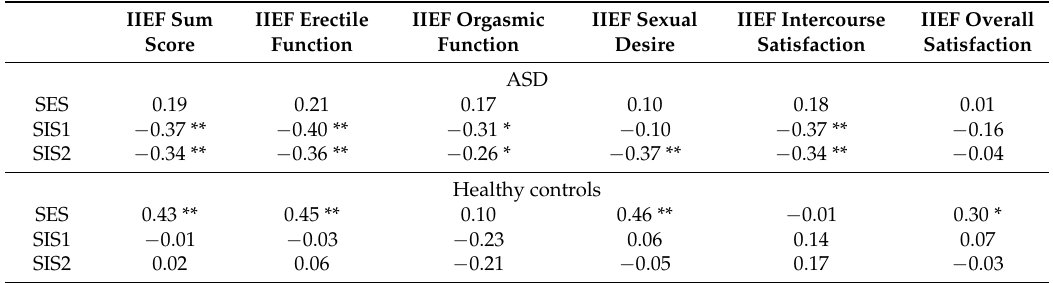
Table 5. Correlational analysis between the SIS/SES and male sexual functioning assessed with the